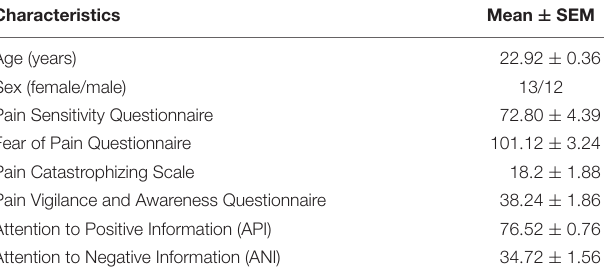
= 0 . 138). Post hoc paired-sample TABLE 1 | Demographic and psychometric characteristics of participants ( n = ( F 2 , 48 = 3.83, p = 0.035, η 2 p